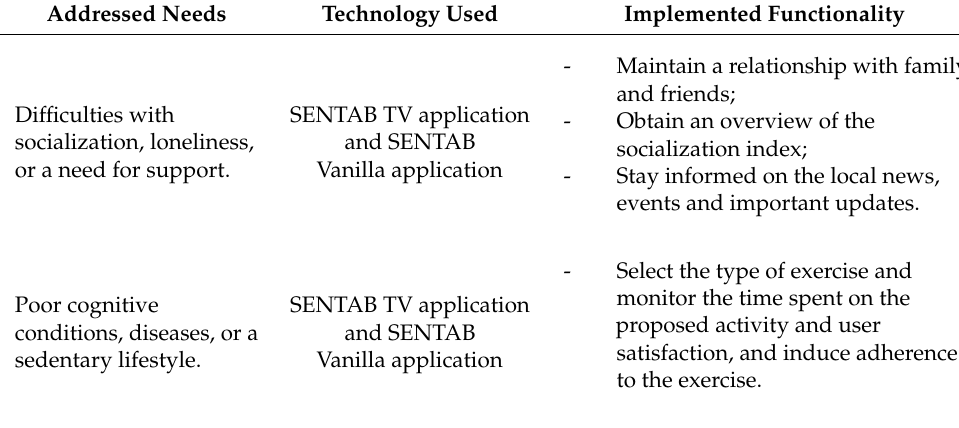
Table 2. Socialization and stimulation